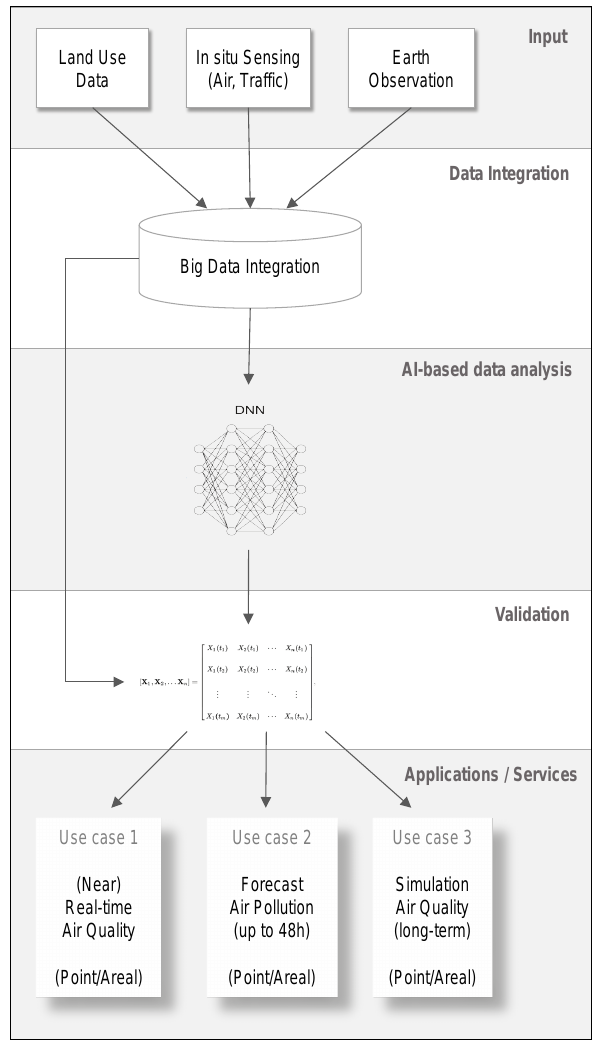
Figure 5: 48-hour forecast for NO2 concentrations at the station “Köln-Rodenkirchen” for November 13 th and 14 th ,